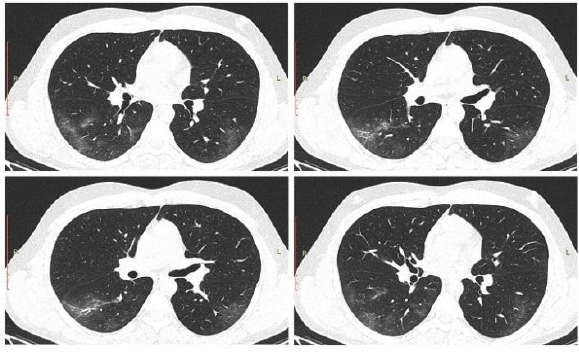
Figure 9 . CT image of patient 2, first day of illness.